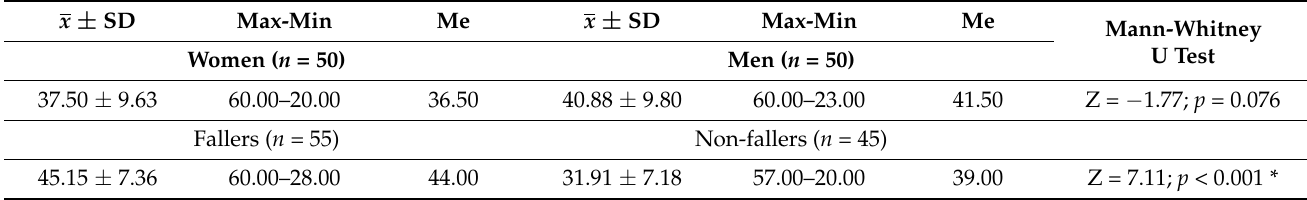
Table 3. Comparison of the FES-I values in the groups by gender and the fact of suffering a fall in the last year.